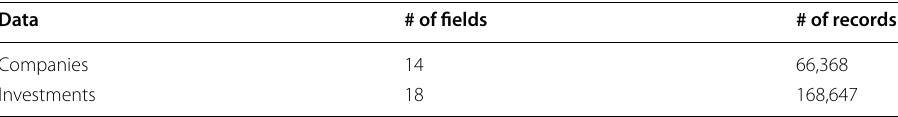
Table 4 Simple statistics of the benchmark dataset. # “Companies” dataset lists all businesses. “Investments” dataset lists all investments investors made to the